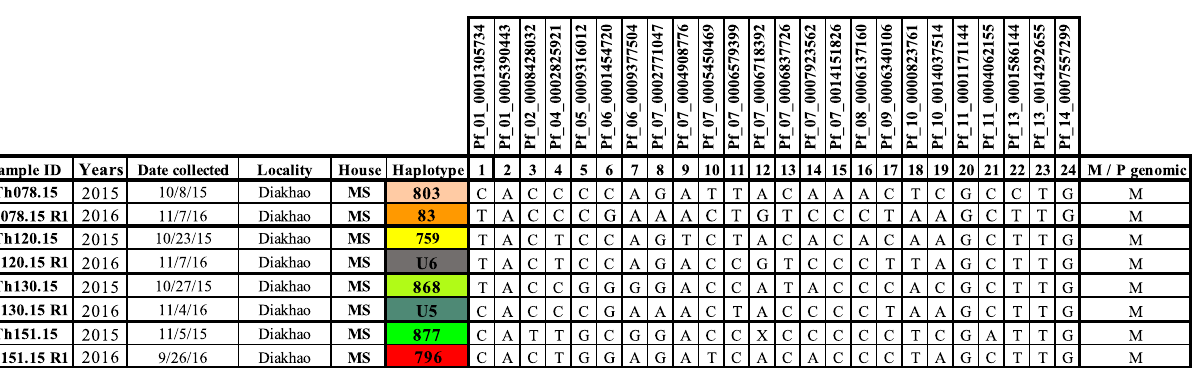
Figure 4. Barcodes of initial and re-infected participant samples. Patient ID (human) is shown along with date of sampling, Age, Neighborhood, Household (arbitrary alphabetical code), and barcode haplotype. SNP positions are indicated for the 24-SNP barcode. “N” indicates a position with two peaks—corresponding to both biallelic SNPs (mixed genotype), and an “X” indicates a reproducibly negative call. M/P genomic indicates monogenomic (M) or polygenomic (P)